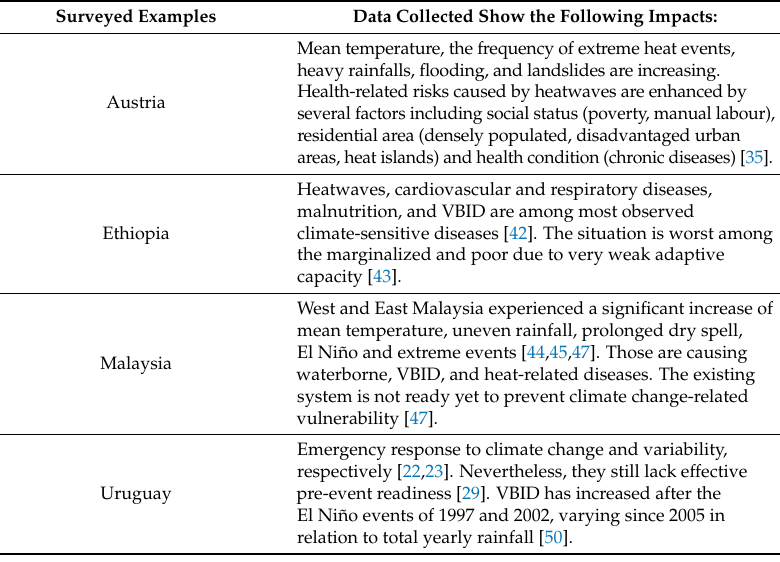
Table 4. Summary of overall impacts on well-being and environmental